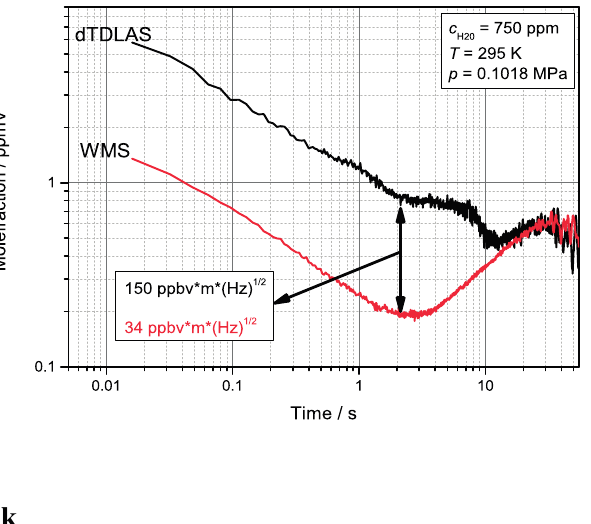
Figure 15. Allan deviation the time division multiplexed dTDLAS and WMS measurement at c H2O = 750 ppmV. The normalized 2f/1f WMS need less averaging to receive a normalized precision of 34 ppbV·m·(Hz) 1/2